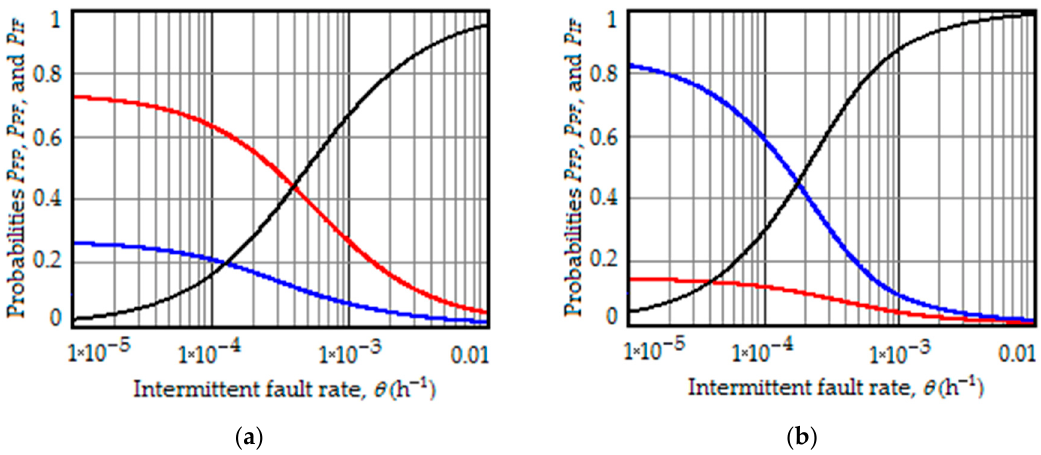
Figure 7. Dependences of the posterior probabilities of dismounting the LRU due to the in-flight false-positive (red curve), intermittent fault (black curve), and permanent failure (blue curve) on the intermittent fault rate when 𝜆 = 10 (cid:2879)(cid:2872) h (cid:2879)(cid:2869) ; ( a ) 𝑃 (cid:3033)(cid:3039)(cid:3036)(cid:3034)(cid:3035)(cid:3047)(cid:3007)(cid:3017) = 1 × 10 (cid:2879)(cid:2871) ; ( b ) 𝑃 (cid:3033)(cid:3039)(cid:3036)(cid:3034)(cid:3035)(cid:3047)(cid:3007)(cid:3017) = 1 × 10 (cid:2879)(cid:2872) .